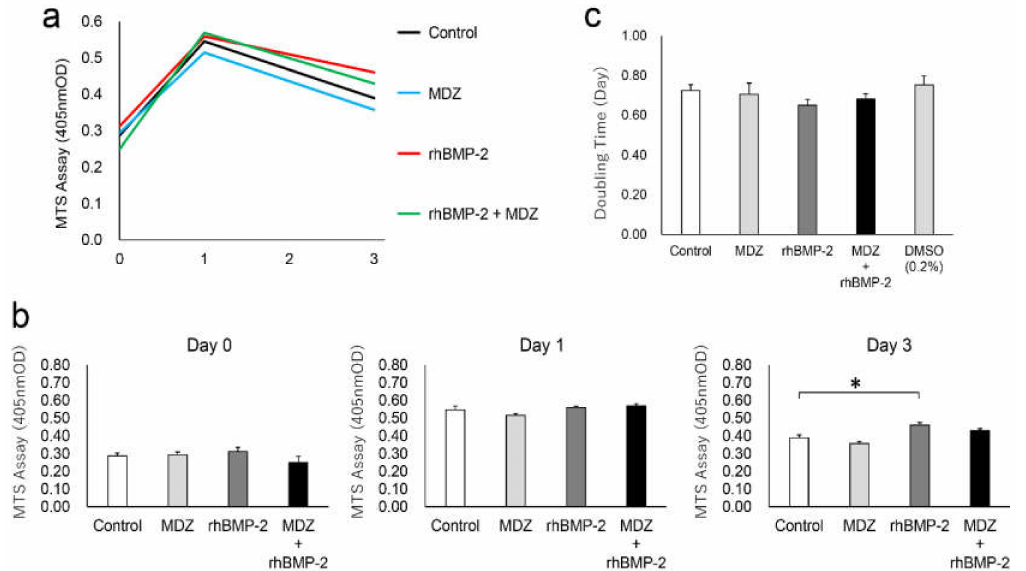
Figure 2. Cytotoxicity of MDZ for cell proliferation rate of C2C12 cells and for cultured cells after confluence incubated for di ff erent periods. ( a ) Changes in cell proliferation over time by MTS assay; ( b ) Comparison of cell proliferation on days 0, 1, and 3. C2C12 cells in the absence (Control) or presence of MDZ alone (MDZ), rhBMP-2 alone (rhBMP-2), and the combination of rhBMP-2 and MDZ (rhBMP-2 + MDZ) on days 0, 1, and 3 were cultured at a final volume of 120 µ L / well for 1 h at 37 ◦ C. MTS reagent was added, and an absorbance of 450 nm was recorded using a microplate reader ( n = 8 tests per sample). Values are the means ± SEM (* p < 0.01, Steel’s test). ( c ) Cell population doubling level against